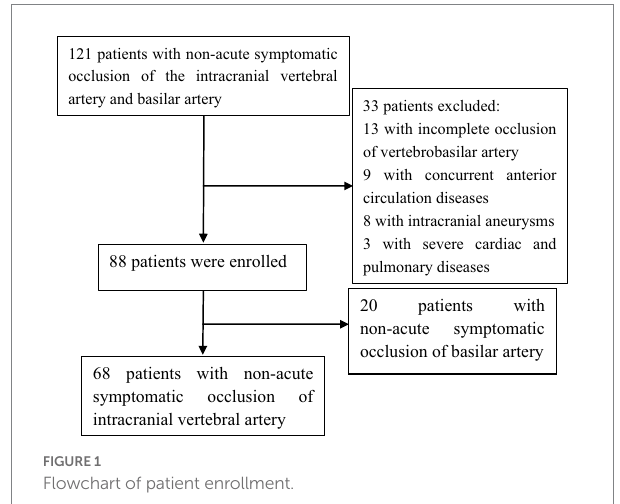
FIGURE 1 Flowchart of patient